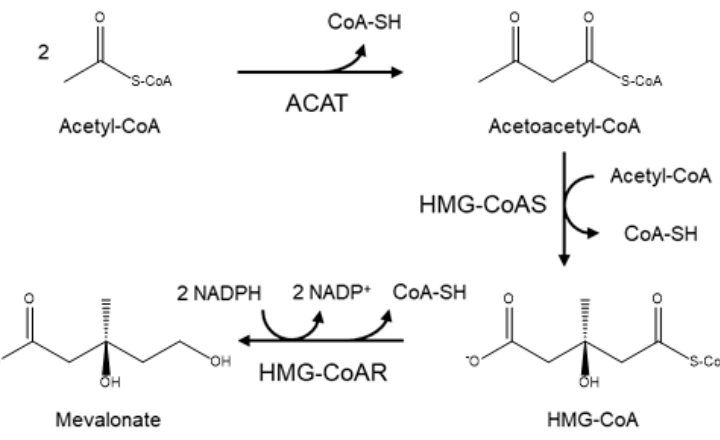
Figure 4. Diagram of the mevalonate pathway, the first stage in the biosynthesis of cholesterol.